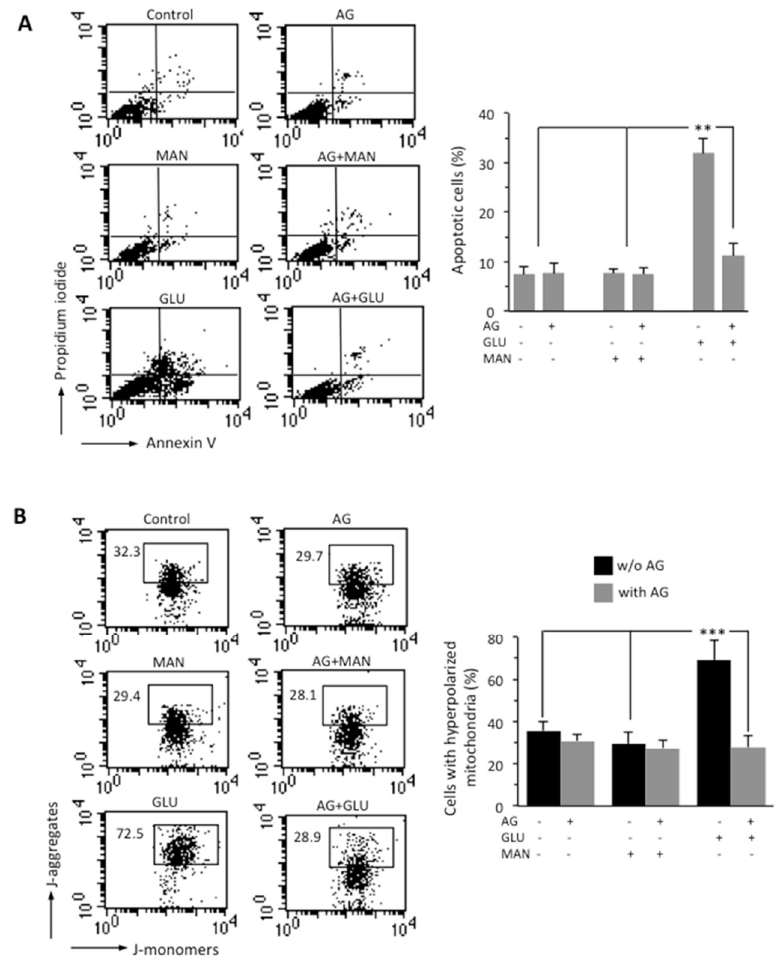
Figure 2. SH-SY5Y neuroblastoma cells were treated with 300 mM GLU or MAN alone or in combination with 1000 μ g/mL AG for 48 h. ( A ) FACS analysis after double cell staining with Annexin V/PI. Left panels. Dot plots from a representative experiment are shown. Numbers represent the percentages of Annexin V-positive cells (bottom-right quadrant), Annexin V/PI double-positive cells (upper right quadrant), or PI-positive cells (upper left quadrant). Bar graph shows results obtained from four independent experiments, reported as means ± SD. ( B ) Left panels. Representative dot plots of the FACS analysis of MMP, performed by using JC-1. Numbers in the boxed areas indicate the percentage of cells with high MMP (hyperpolarized mitochondria). Bar graph shows the percentage of cells with hyperpolarized mitochondria obtained from three independent experiments and reported as percentage ± SD. ** is for p < 0.01, and *** is for p < 0.001.